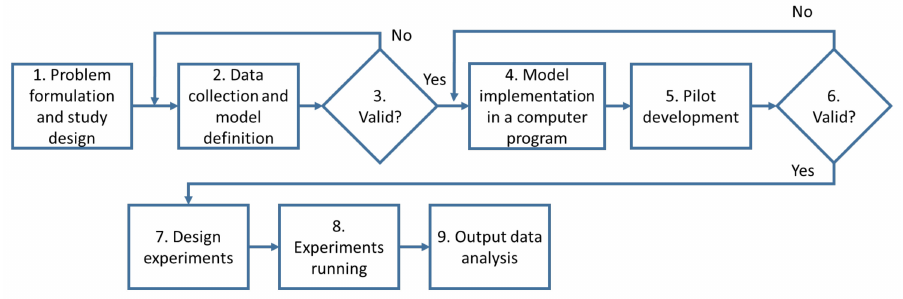
Figure 1. Simulation steps (authors’ elaboration from